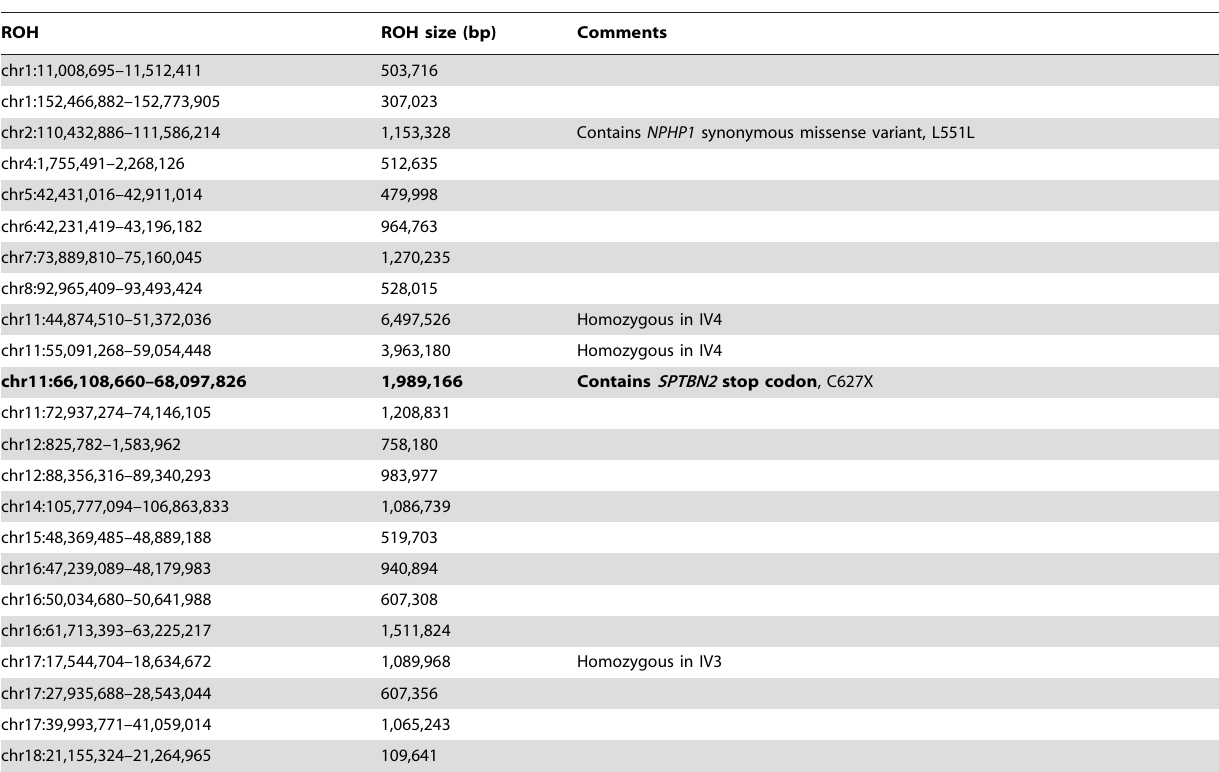
Table 2. Regions of homozygosity in V1, V2, and V3.